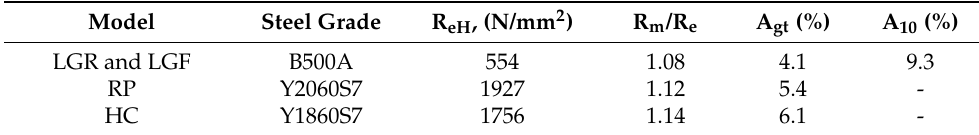
Table 3. Properties of reinforcement steel and prestressing steel used in the test model and determined in accordance with the standards [63–65].